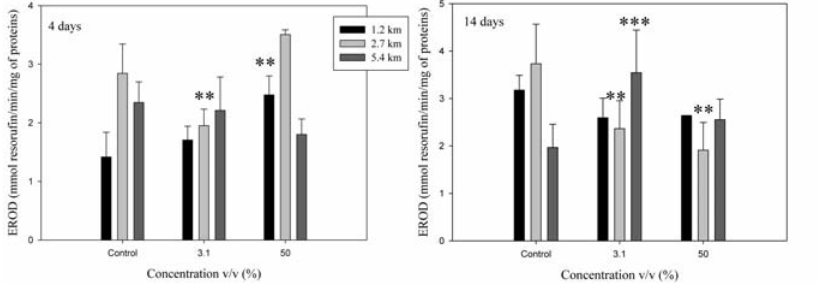
Figure 2. Ethoxyresorufin O-deethylase (EROD) activity in trout liver after 4 and 14 days exposure to groundwater at 1.2 km, 2.7 km and 5.4 km. Data are presented as mean±standard error. Asterisks indicate significant difference from controls (**P ***P 0.001). <